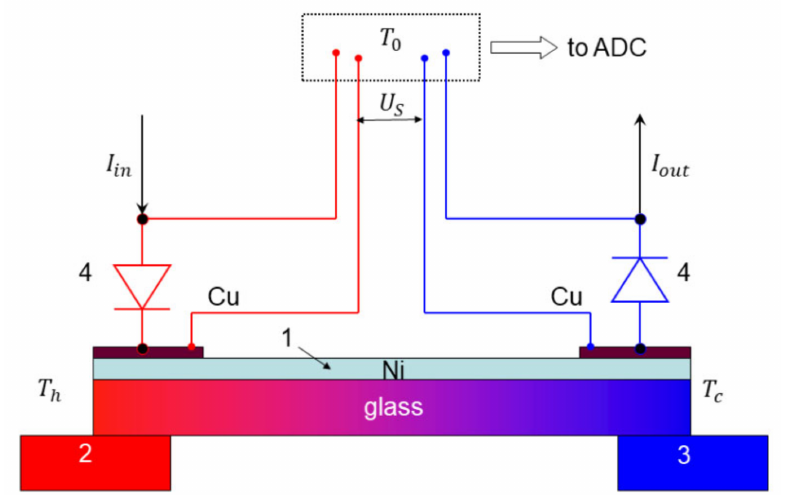
Figure 3. Schematics of experimental configuration for measuring Seebeck coefficient. 1—sample, 2—heater, 3—thermostat (temperature-controlled heat sink), 4—diode temperature